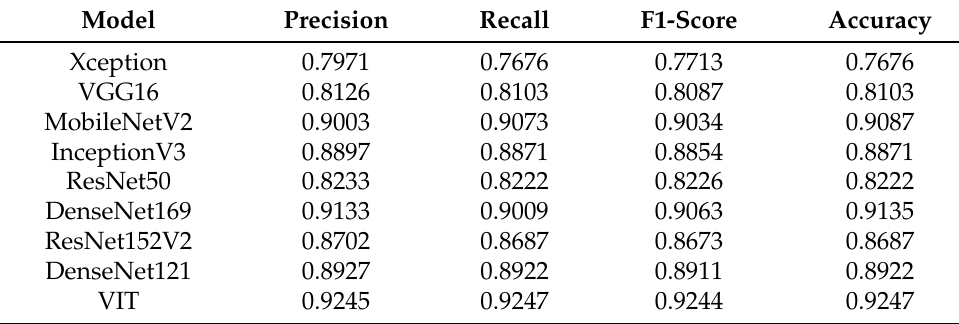
Table 1. The results of well-known CNN models.